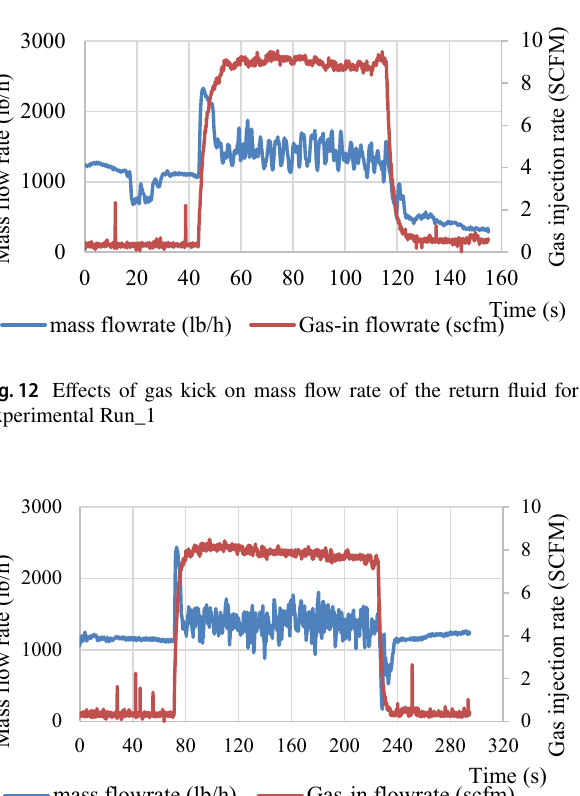
Fig. 8 Effects of gas kick on bottomhole pressure for experimental